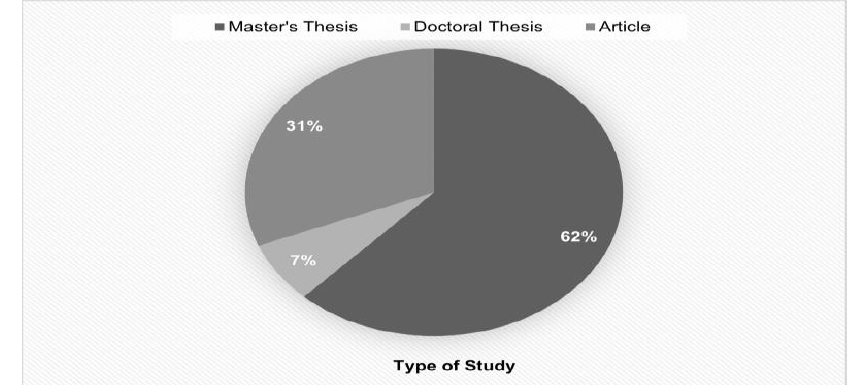
Figure 1: Distribution of Studies by Publication Type